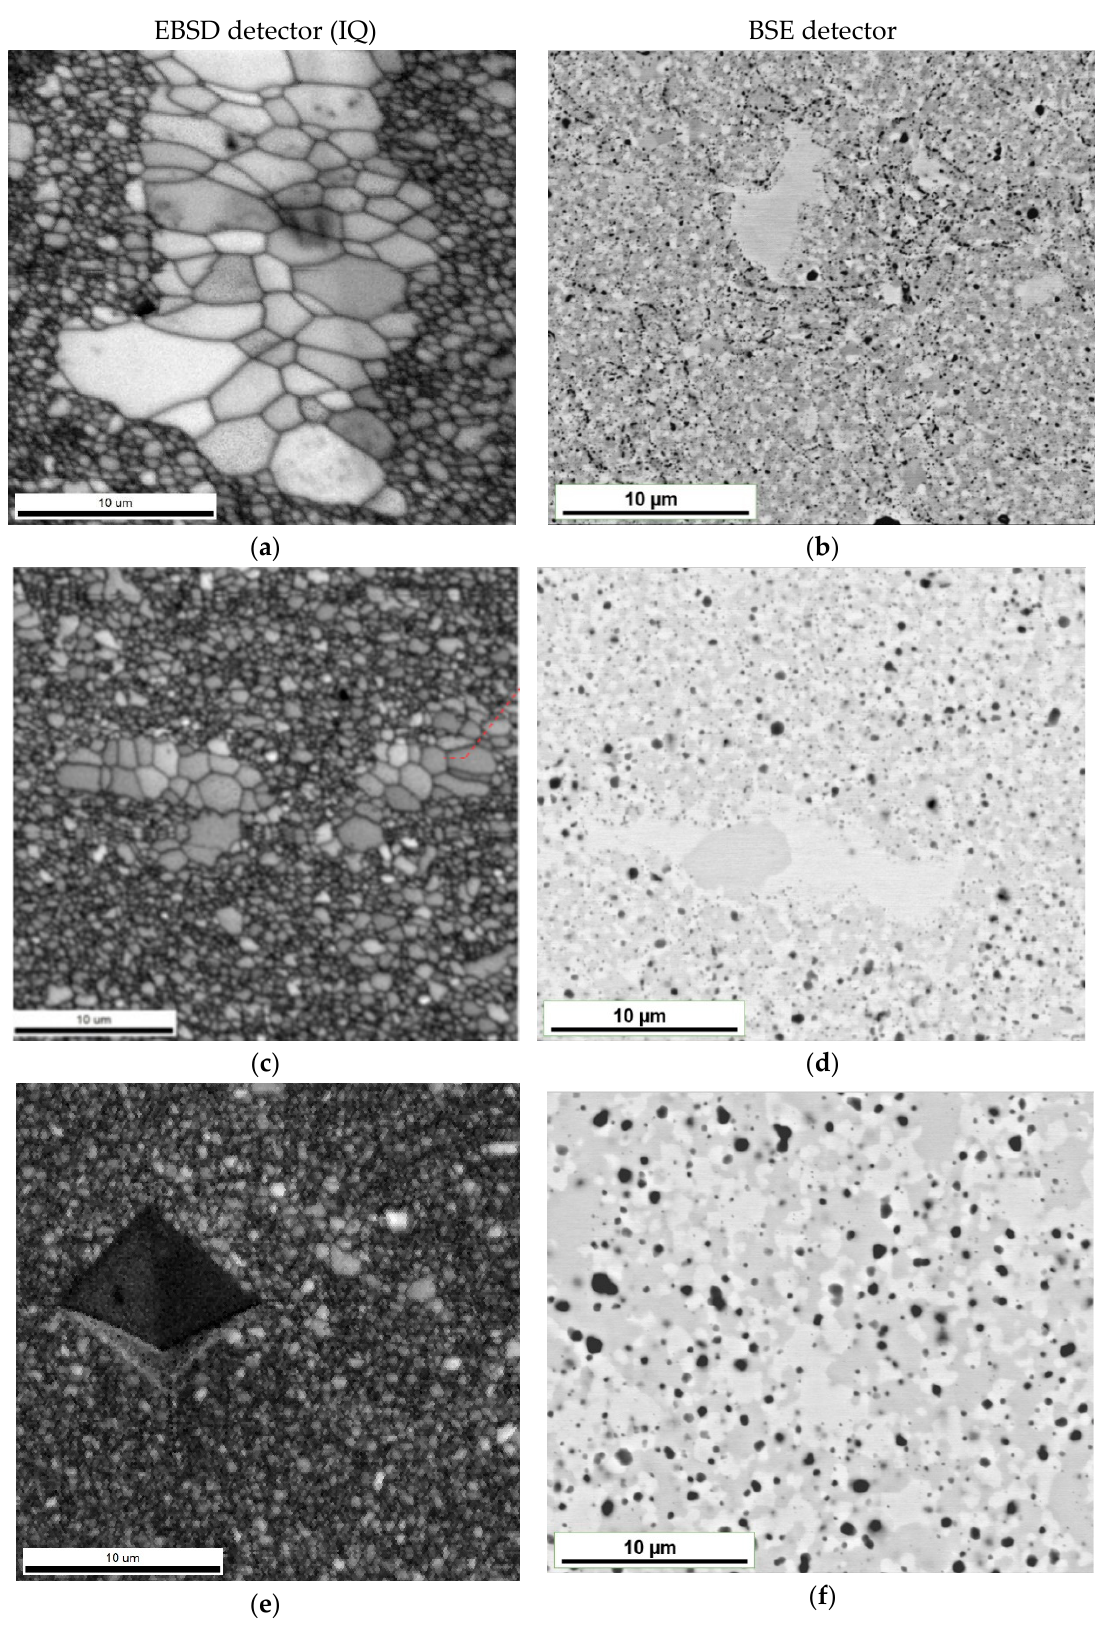
Figure 4. Two-phase microstructure of TiCoCrFeMn alloy with large bright areas disappearing as a function of homogenization time after annealing during 1 h ( a , b ), 100 h ( c , d ) and 1000 h ( e , f ).